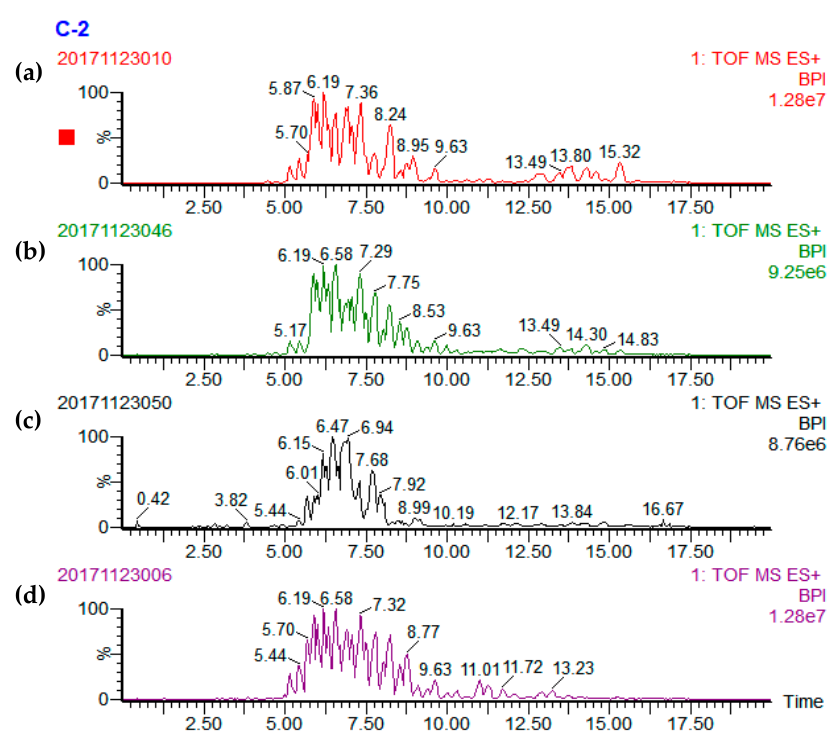
Figure 1. UPC 2 / Q-TOF MS BPI chromatograms of ( a ) cucumber, ( b ) pumpkin, ( c ) carrot, and ( d ) tomato seed oil samples. BPI stands for base peak integration.